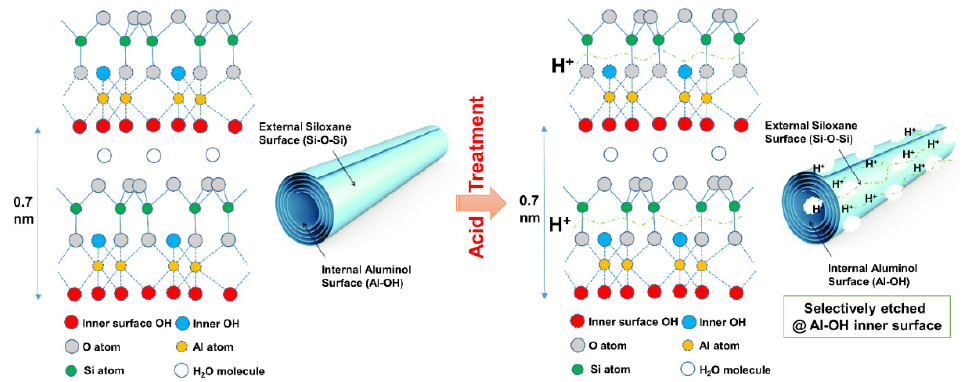
Figure 2. Possible etching mechanism of HNT by sulfuric acid.